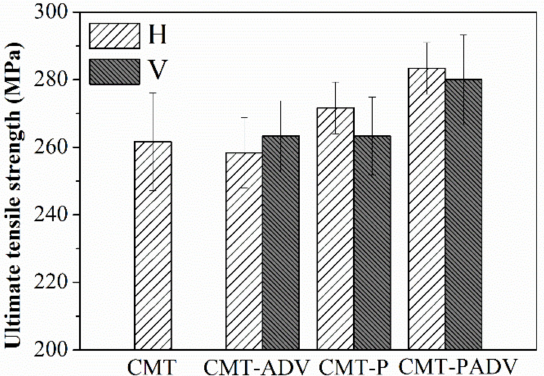
Figure 11. Tensile properties for the 2219 alloys fabricated by different arc modes.